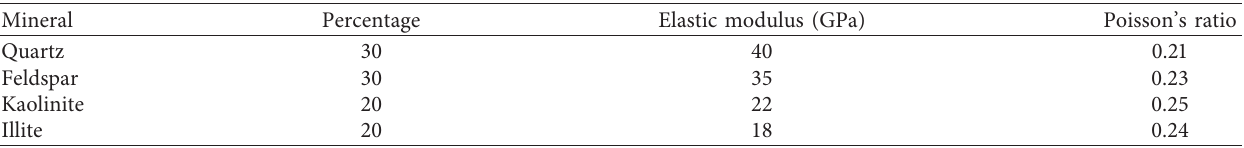
Figure 2: (a) 2D geometric model with its dimensions. The notch was 0.3mm wide and 1.15 mm high. For the ease of reference, the left boundary of the model is marked as L, the lower left boundary is marked as LD, the right boundary is marked as R, and the upper right boundary is marked as RU. (b) Heterogeneous rock mineral model, quartz, feldspar, kaolinite, and illite are represented by gray scales from high to low. Table 1: Mineral composition and parameters of CPE4 of different